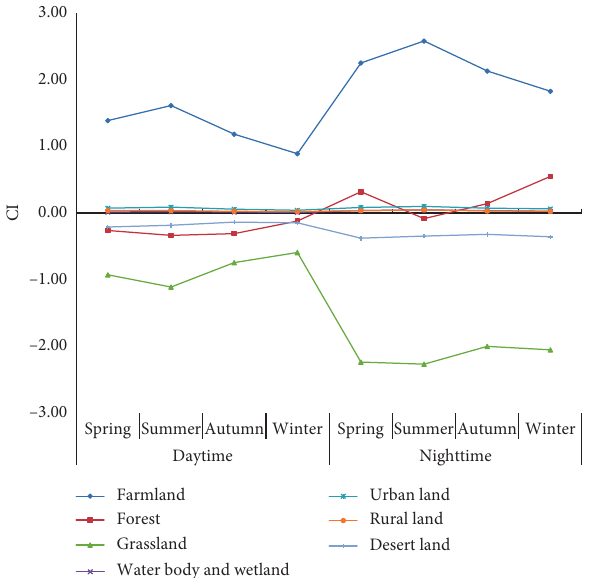
Figure 6: The seasonal CIs of different land use types for the regional thermal environment in